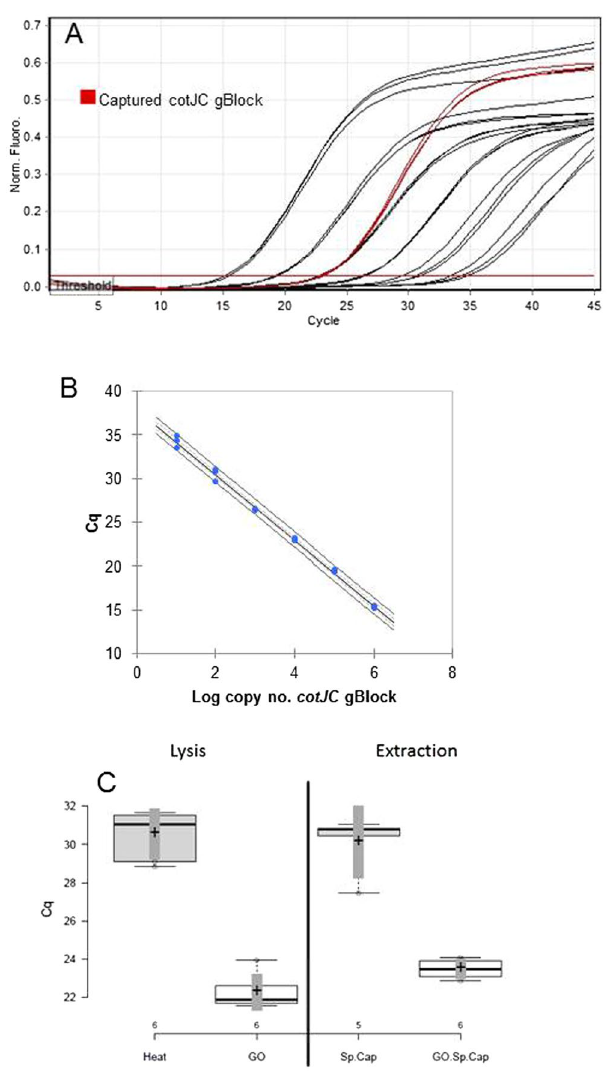
Figure 5. Bacillus spores are inefficiently lysed by heat step. ( A ) Standard curve of 1,000,000, 100,000, 10,000, 1,000, 100 and 10 cotJC gBlock copies in triplicate. Red curves are extracted DNA in triplicate. ( B ) cotJC qPCR assay is linear. Equation of line: y = − 3.74x + 37.96; (95% CI slope − 3.86, − 3.62) R 2 = 0.996, qPCR efficiency = 85.1%. ( C ) Box and whisker plot demonstrating that sample prep method did not sufficiently liberate B. atrophaeus spore DNA. Center lines show the medians; box limits indicate the 25th and 75th percentiles as determined by R software; whiskers extend to minimum and maximum values; crosses represent sample means; vertical dark gray bars indicate 95% confidence intervals of the means; data points are plotted as open circles. Samples indicated by: Heat = heat lysis; GO = GeneOhm kit; Sp.Cap = specific capture protocol; GO.Sp.Cap = GeneOhm lysis followed by specific capture protocol. n = 6, 6, 5, and 6 sample points,